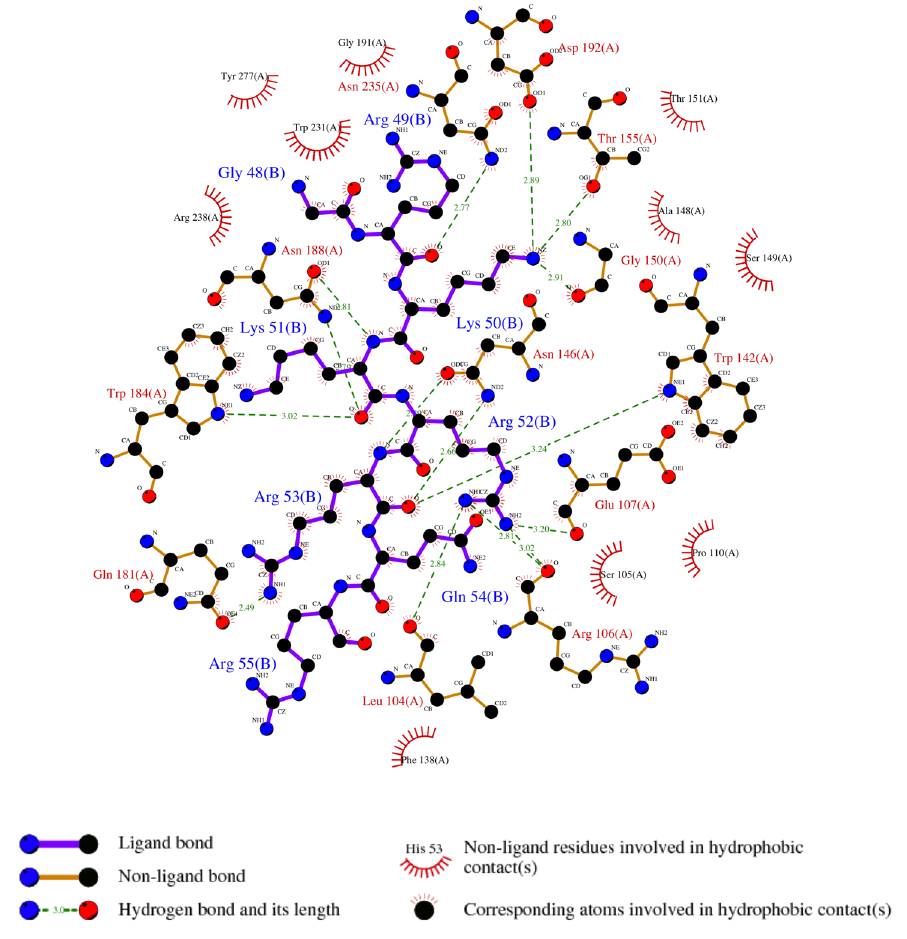
Figure 4. LigPlot interaction schematic for Tat:NLS/CPP importin- α structure. Tat:NLS/CPP intramolecular bonds are shown as solid purple lines, importin- α intramolecular bonds are shown as solid orange lines. Importin- α residues involved in hydrophobic contacts are shown as multiple red fanning lines. Corresponding atoms involved in hydrophobic contacts are shown with small orange fanning lines. Hydrogen bonds and their length are shown as green dotted lines. Figure was made using LigPlot 34 .